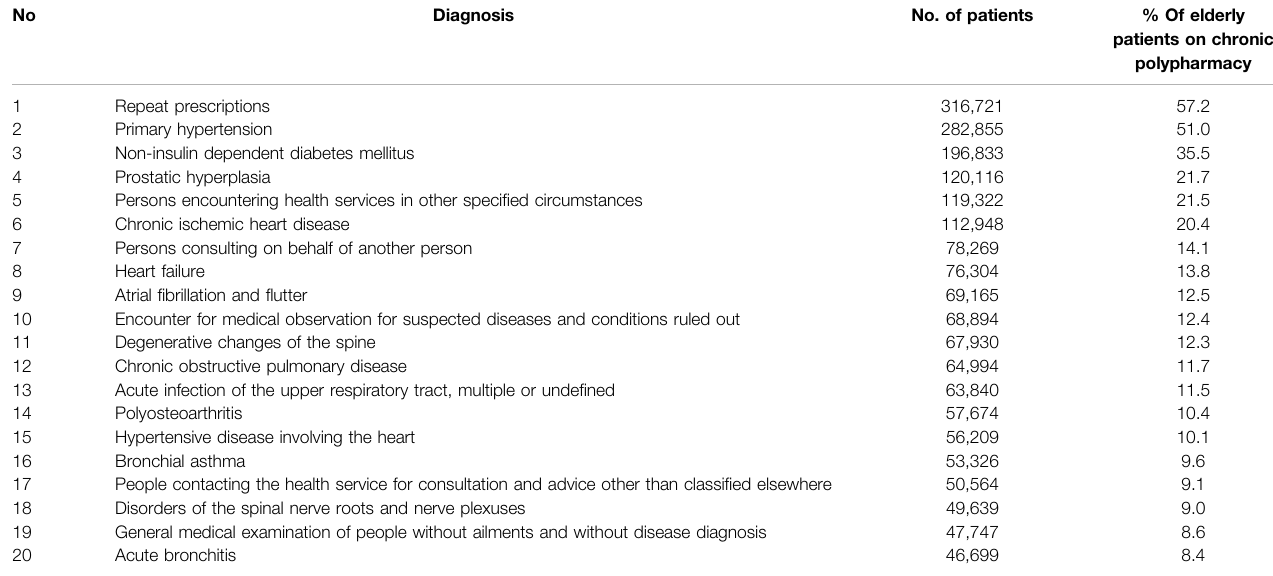
TABLE 4 | Top-20 principal diagnoses in selected patients on chronic polypharmacy in 2018 by healthcare services other than hospitalisation.